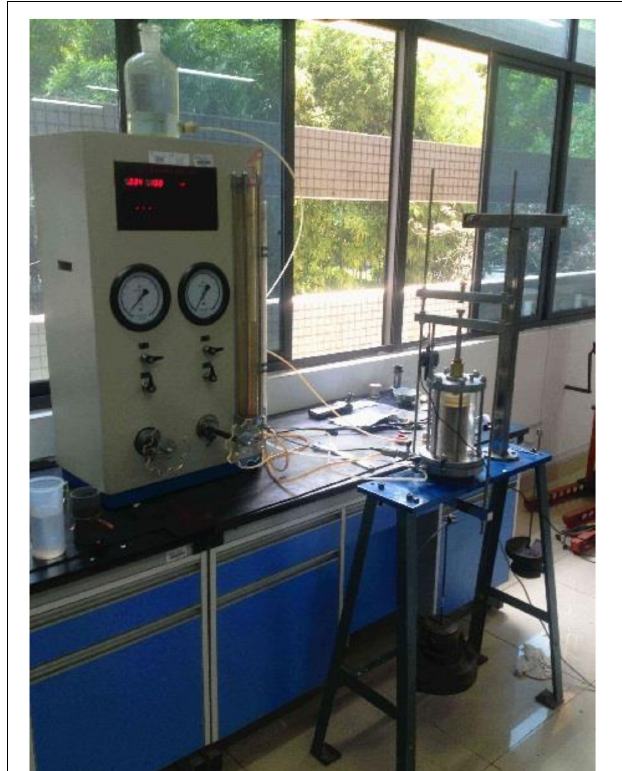
FIGURE 4 | Triaxial rheology apparatus (TRA-001).